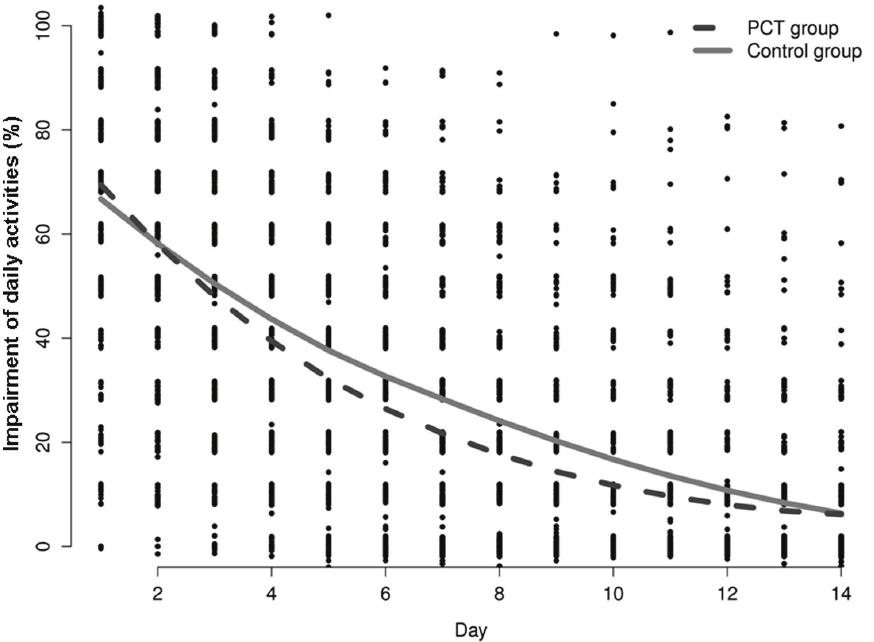
Figure 2. In comparison with clinical guidelines, PCT guidance